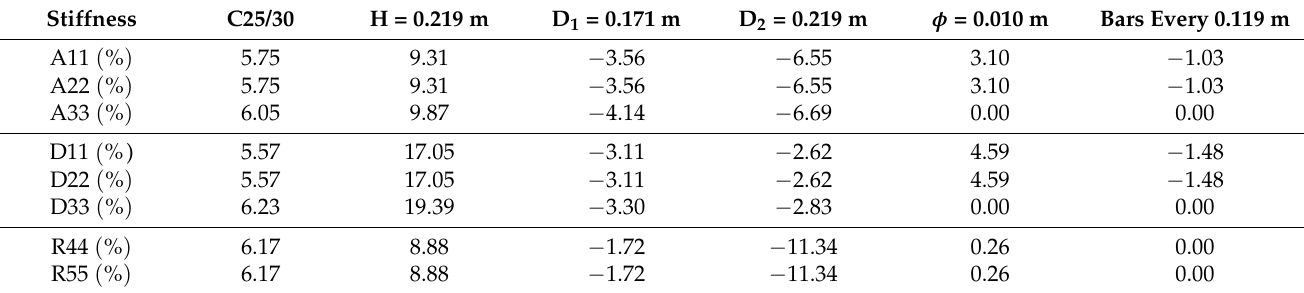
Table 9. Normalized stiffness for RVE